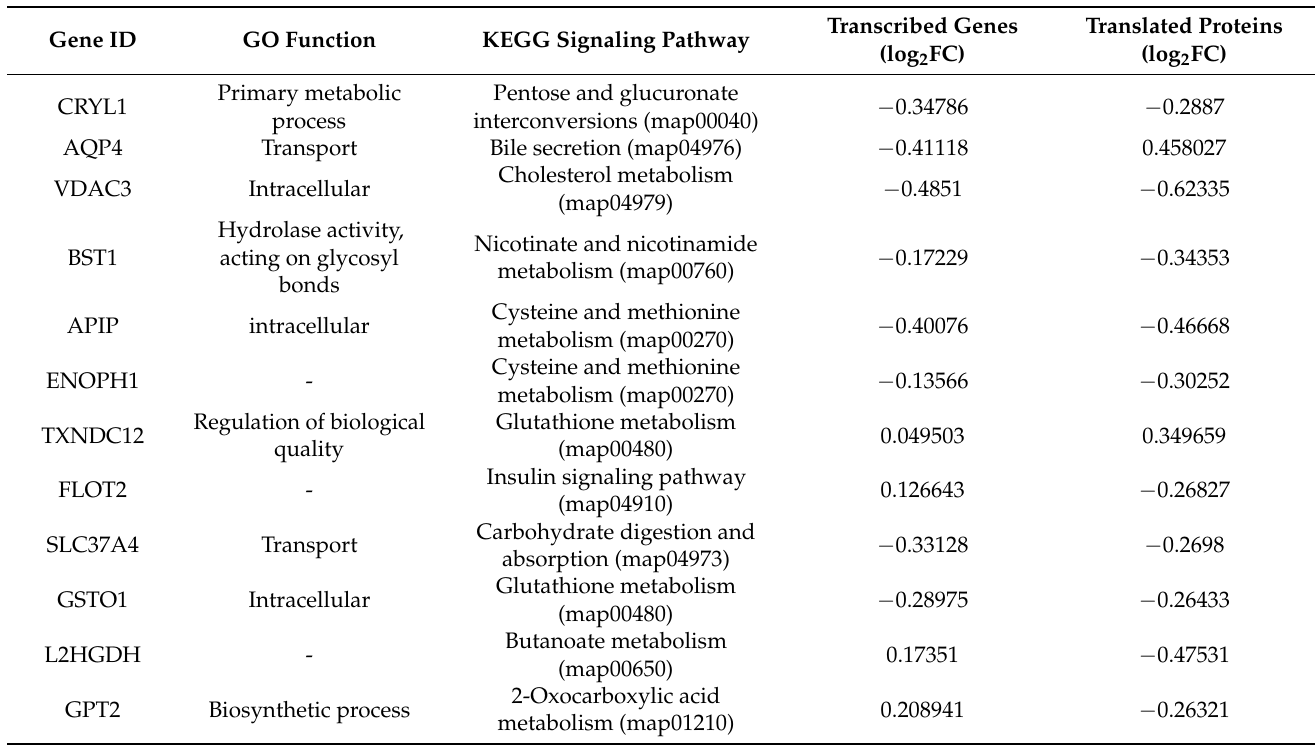
Table 3. GO function, KEGG signaling pathway, and log 2 FC for key differentially expressed genes and proteins involved in rabbit skeletal muscle